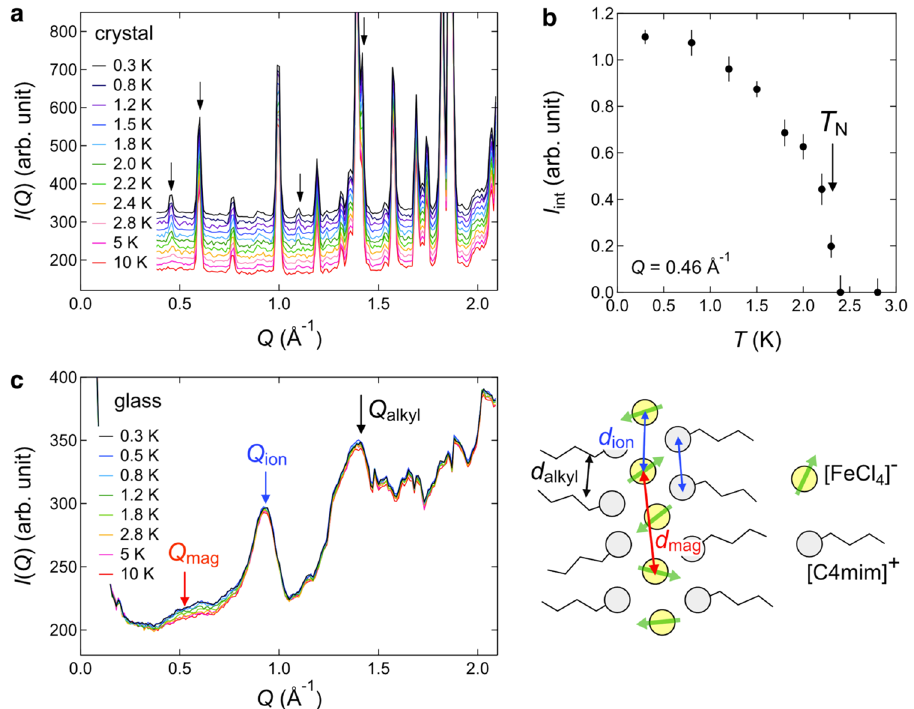
Figure 2. Diffraction patterns of C4mimFeCl 4 . ( a ) Diffraction patterns of crystalline C4mimFeCl 4 between 0.3 and 10 K. Data are shifted upward for clarity. Arrows indicate the magnetic Bragg peaks that appeared below T N . ( b ) Temperature dependence of integrated intensity of the magnetic Bragg peak at Q = 0.46 Å −1 . ( c ) Diffraction patterns of the structural glass of C4mimFeCl 4 and schematic of the molecular and magnetic correlations with specific distances ( d = 2π/ Q